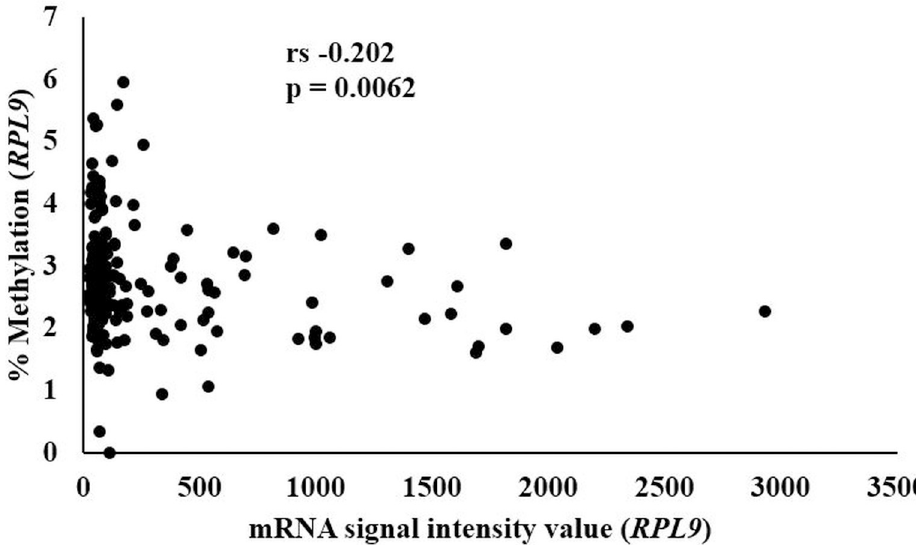
Fig 5. Correlation analysis between RPL9 mRNA and RPL9 methylation. Spearman’s correlation was used to calculate the strength and direction of the relationship between the RPL9 mRNA and RPL9 methylation data. Rho (rs) value of rs -0.202, p =